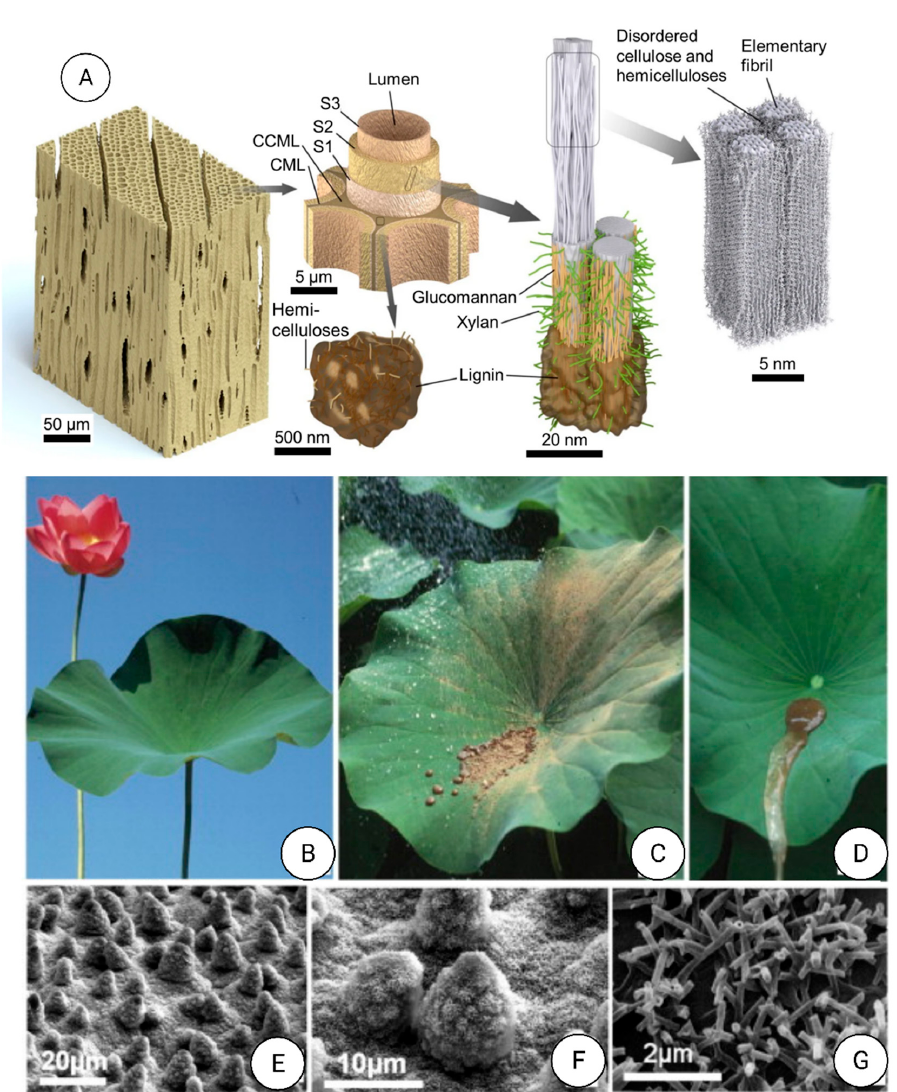
Figure 19. ( A ) Schematic description of softwood structure from the cellular to the nano scale. Secondary cell walls (S1, S2, and S3) are nanofiber-reinforced composites of cellulose fibrils embedded in an organized matrix of amorphous cellulose, hemicelluloses, and lignin. Cellulose is organized in highly ordered elementary fibrils (~3 nm in diameter) that are grouped into bundles to form microfibrils with amorphous polysaccharides [266]; © Nature, 2020; ( B – G ) Images at different magnifications of lotus leaves (Nelumbo nucifera) with self-cleaning properties [267], © Elsevier, 2009. Recently, systemic materials science studies have focused on frequent hierarchical nanostructures in animals to determine how they influence the mechanical properties of various systems (Figure 20) [268]. For instance, some lizards (geckos) and insects (beetles, flies, and spiders) can easily attach to walls and ceilings and move without falling thanks to the micro-and nano-scale structures (fibrillar adhesive system) in their feet. Geckos display the highest adhesion forces in the animal kingdom. The adhesion is due to the versatile and efficient dry adhesiveness of their feet. Electron microscopy analysis of the gecko feet shows three-level hierarchical branched nanostructures with sizes between 200 nm and 5 μ m and spatula-like terminal elements [268].